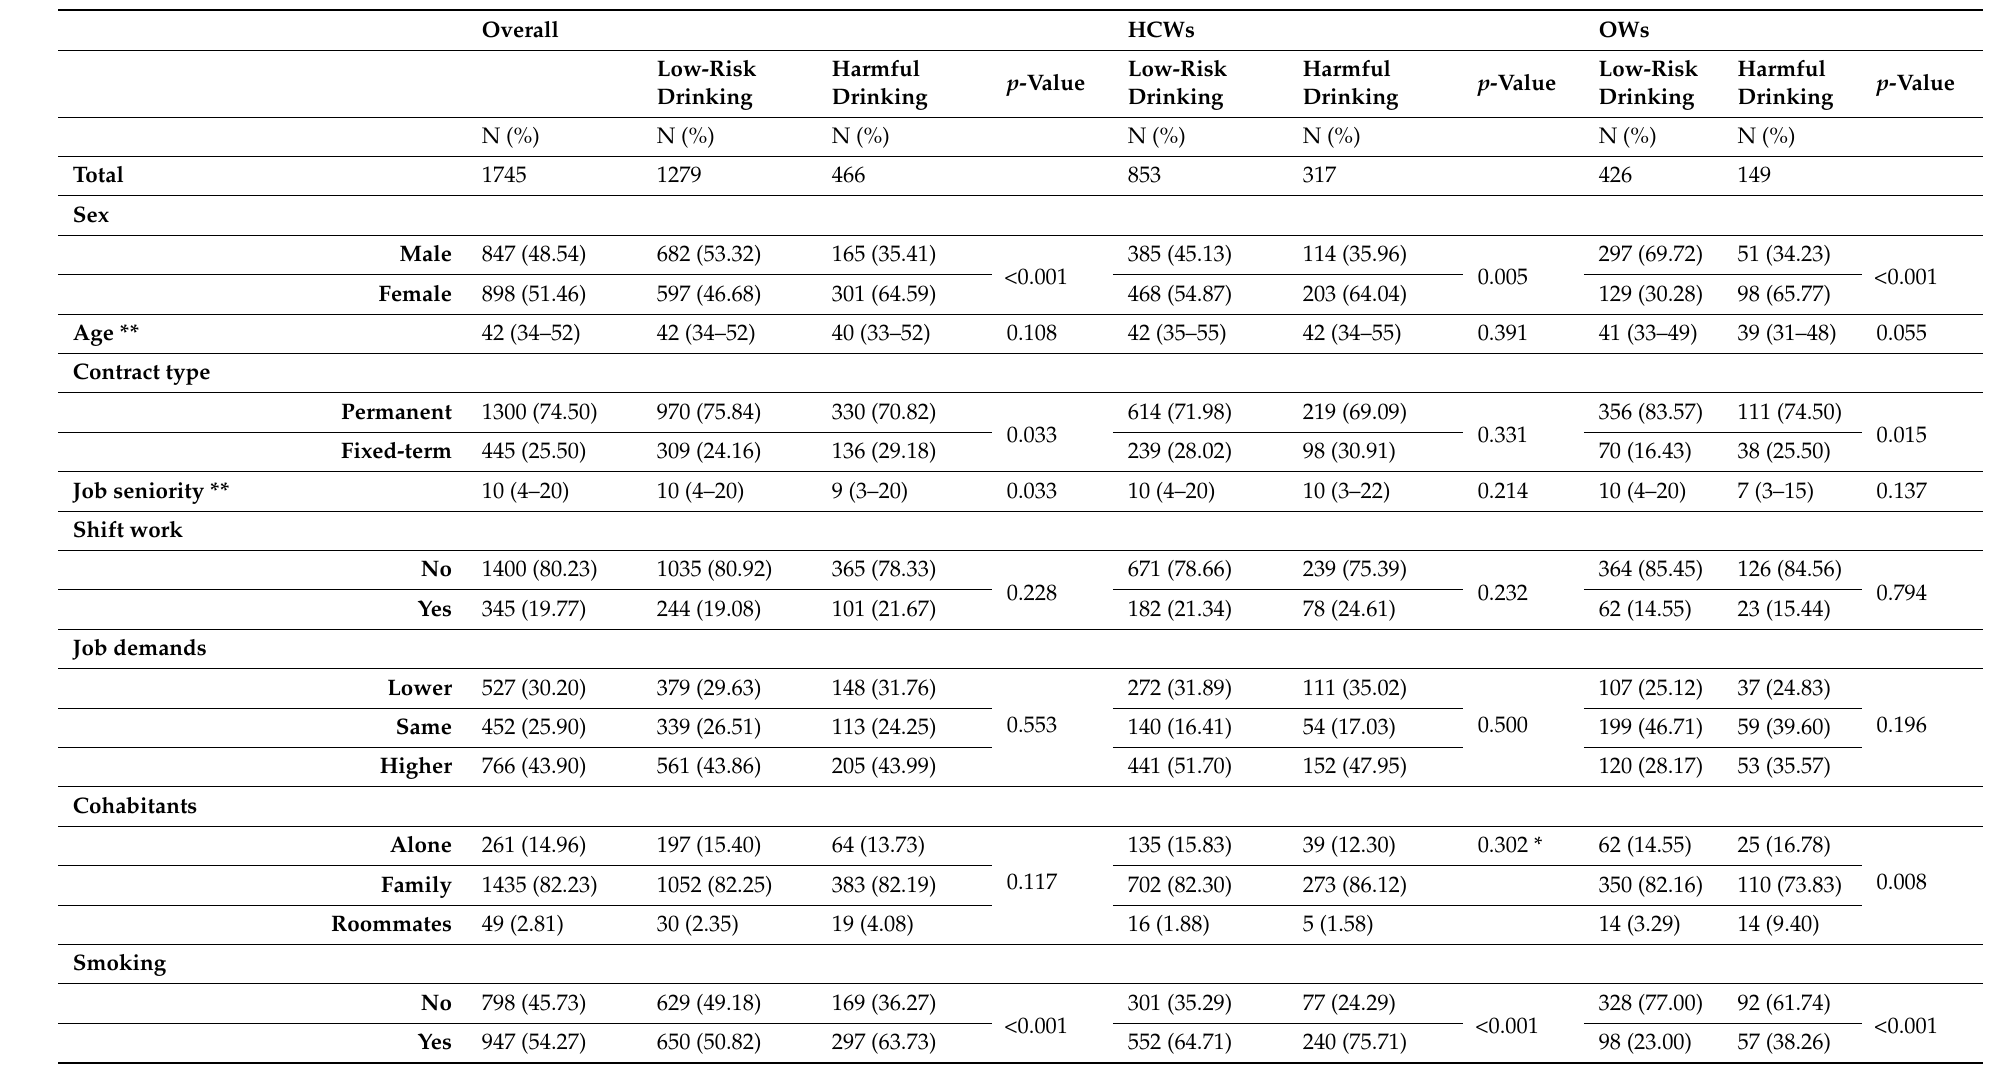
Table 1. Results of the univariate